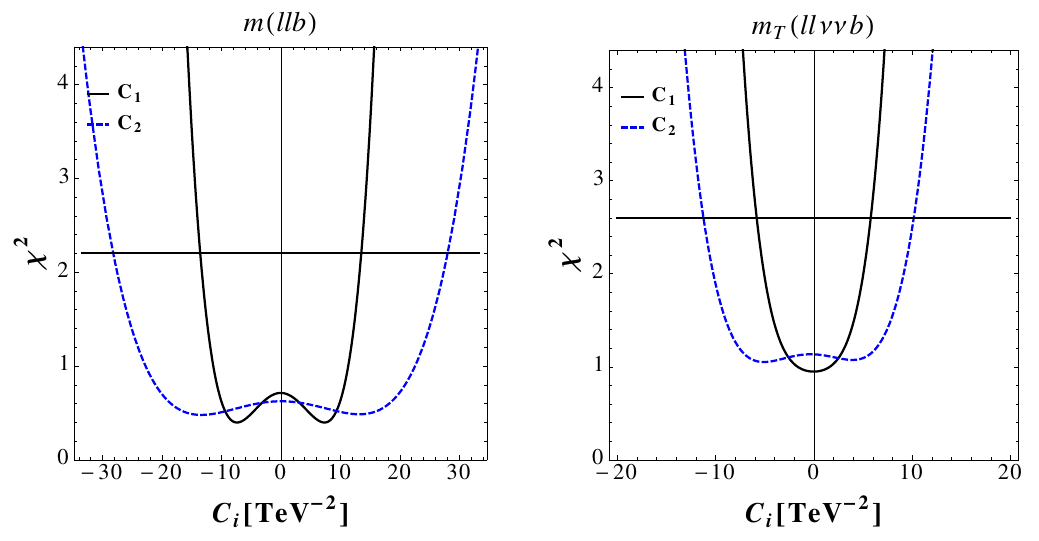
Figure 5 . (cid:31) 2 as function of C 1 (solid black curve) and C 2 (dashed blue curve) obtained by using the m ( llb ) (left plot) and m T ( ll(cid:23)(cid:23)b ) (right plot) di(cid:11)erential distribution measurements at 36.1 fb (cid:0) 1 . x = m ( llb ). On the other hand, parameters are considered excluded at 95% CL if (cid:31) 2 > 2 : 6